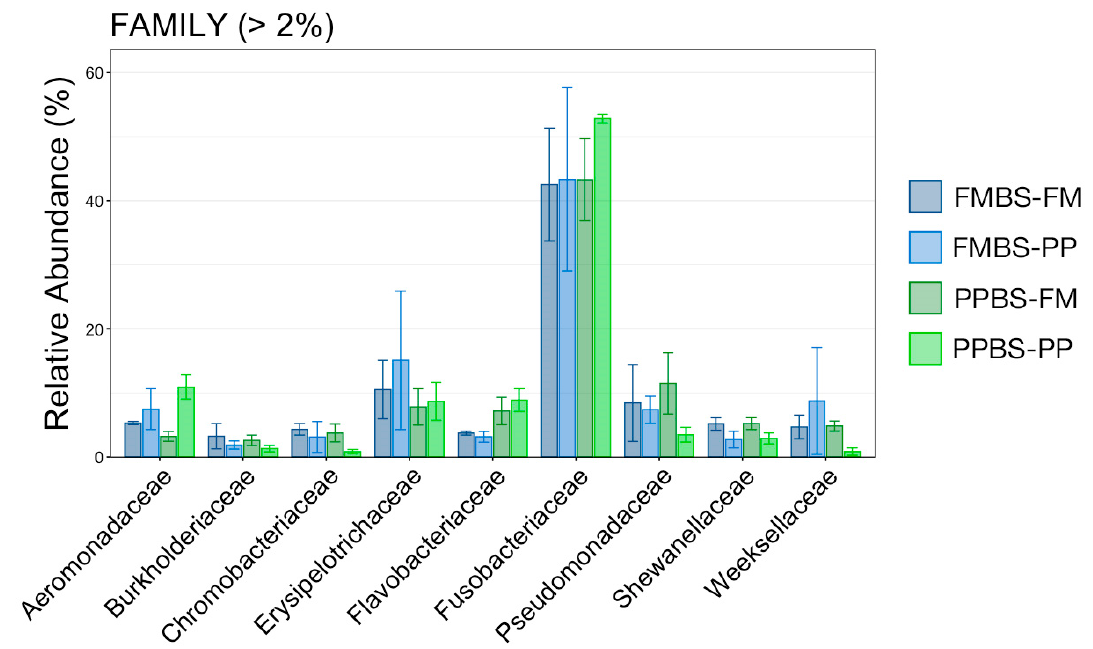
Figure 5. Barplot showing the relative abundance of the nine most abundant taxonomic families within gut microbial communities at 48 dph. Error bars demonstrate the standard error of the mean of the total relative abundance of each family from each treatment group. There were no significant differences (pairwise Wilcoxon rank-sum test, n = 3, p > 0.05). Abbreviations: dph, days post hatch; FM, fishmeal; SBM, soybean meal; FMBS-FM, progeny fish fed FM diet that originated from FM-fed broodstock; FMBS-PP, progeny fish fed PP diet that originated from FM-fed broodstock; PPBS-FM, progeny fish fed FM diet that originated from PP-fed broodstock; PPBS-PP, progeny fish fed PP diet that originated from PP-fed broodstock.